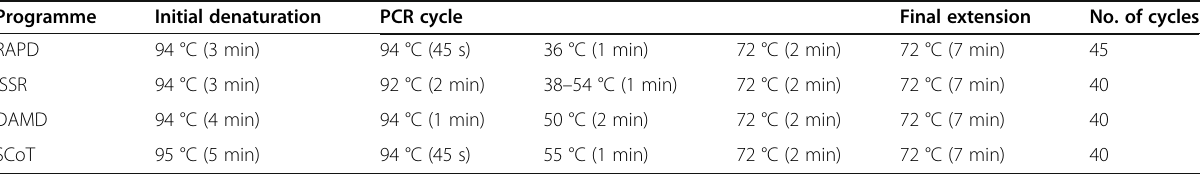
Table. 2 Reaction settings for the PCR